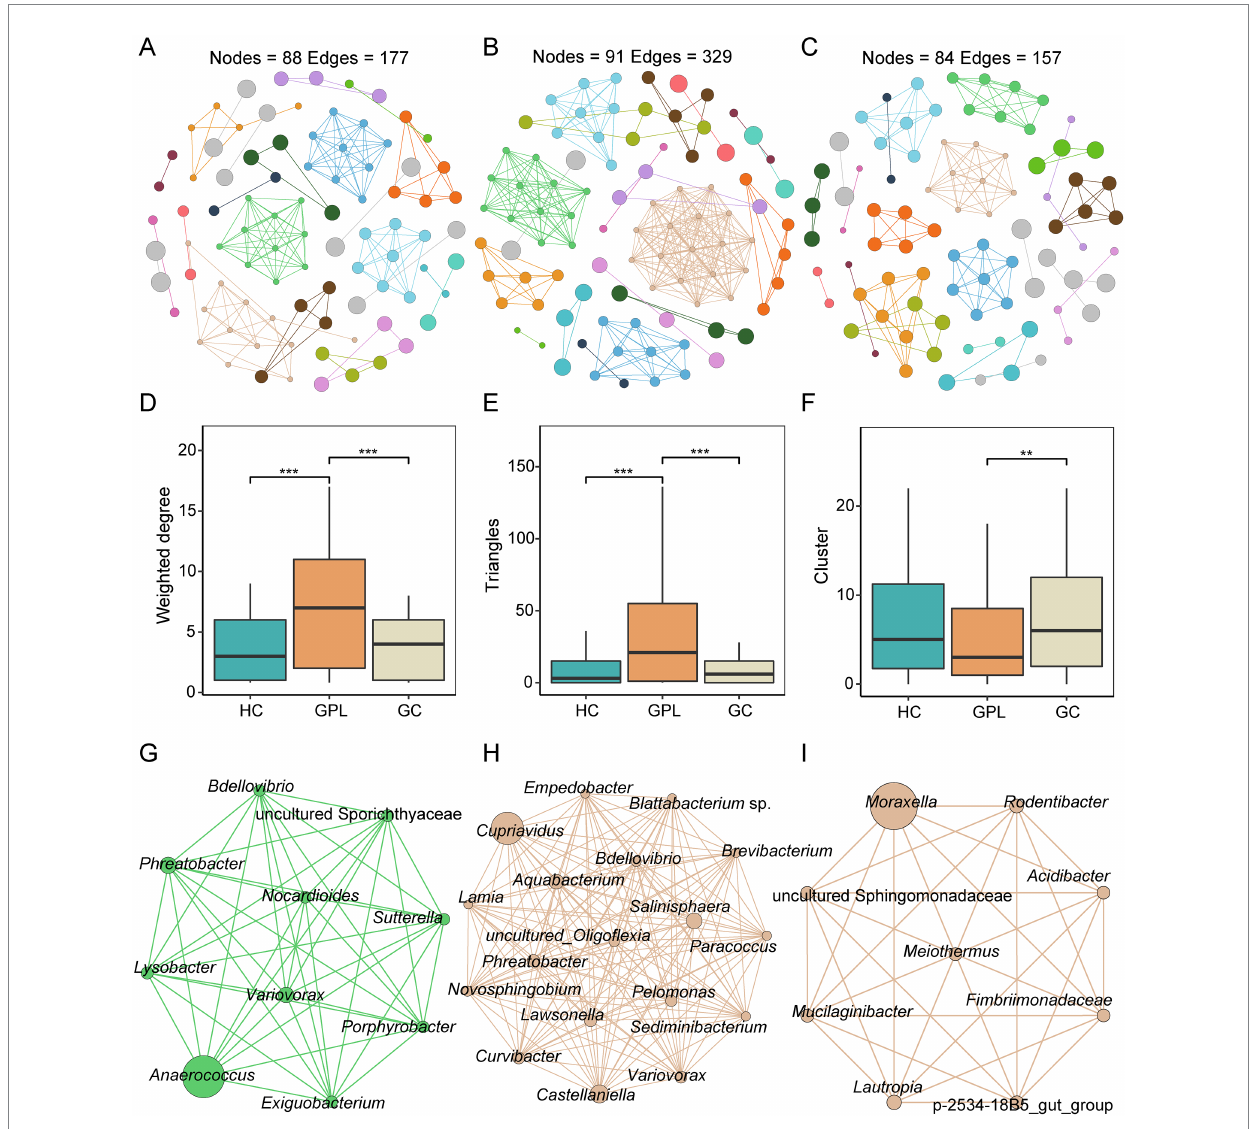
FIGURE 5 Co-occurrence network in three groups. (A) healthy control (HC) network, (B) gastric precancerous lesions (GPL) network and (C) gastric cancer (GC) network. Comparison of network topology properties among groups, weighted degree (D) , triangles (E) , cluster (F) . Wilcoxon test, ** p < 0.01; *** p < 0.001. Co-occurrence hub network, HC (G) , GPL (H) , GC (I)